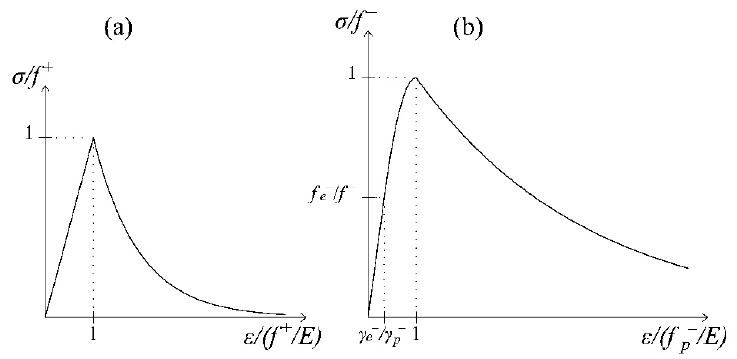
Figure 3. Uniaxial normalized σ - ε curves: ( a ) softening behavior in tension and ( b ) in compression.